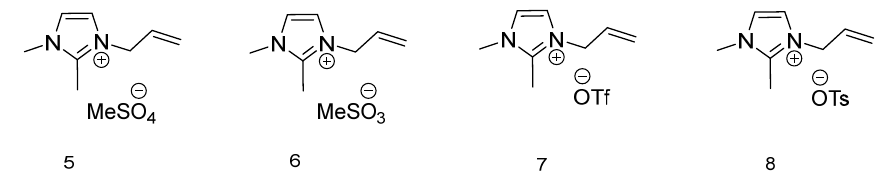
Figure 2. Structures of ionic liquids based on 1-allyl-2,3-dimethylimidazolium cation.